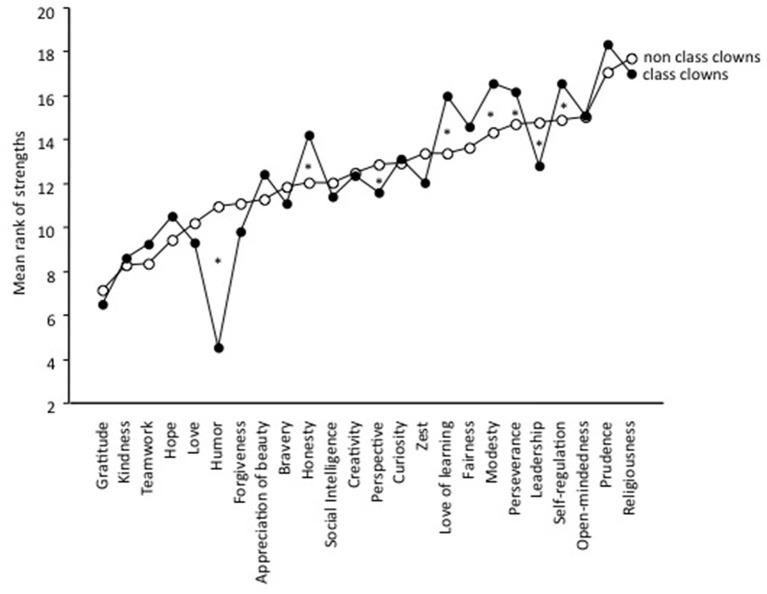
Mean ranks in the 24 strengths for class clowns and non-class clowns separately.